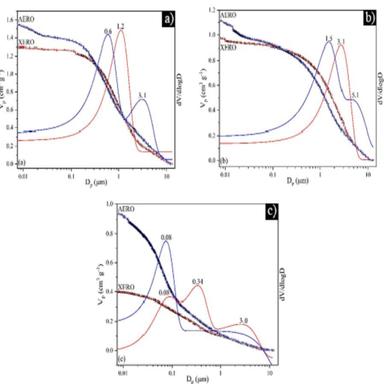
Pore size distribution curves of a) PLACHLX and PLACHLA, b) PLADHMX and PLADHMA, and c) PLAF CHLX and PLAF CHLA samples.